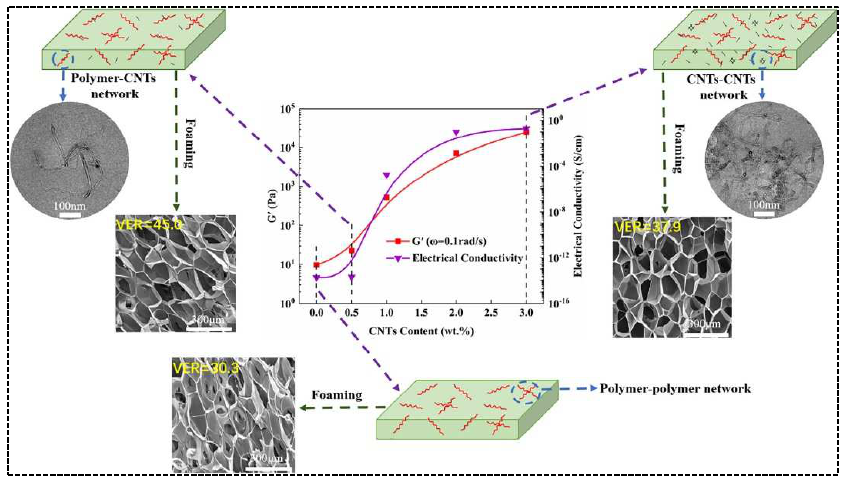
Figure 9. Schematic diagram of three possible network structures of PLA/CNTS foams (reproduced with permission from Reference [95], Copyright 2020 Elsevier).